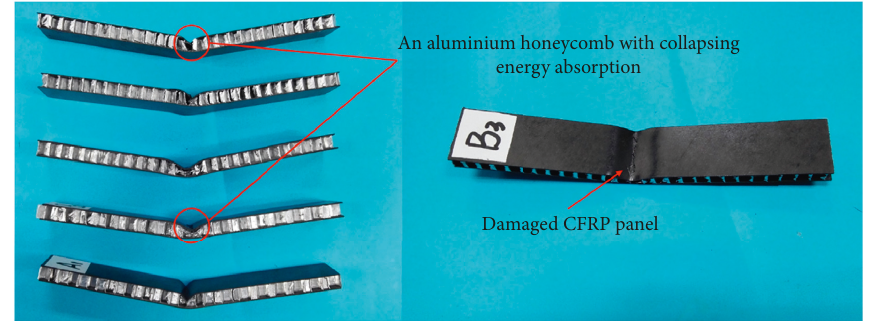
Figure 8: Damaged specimens after quasistatic